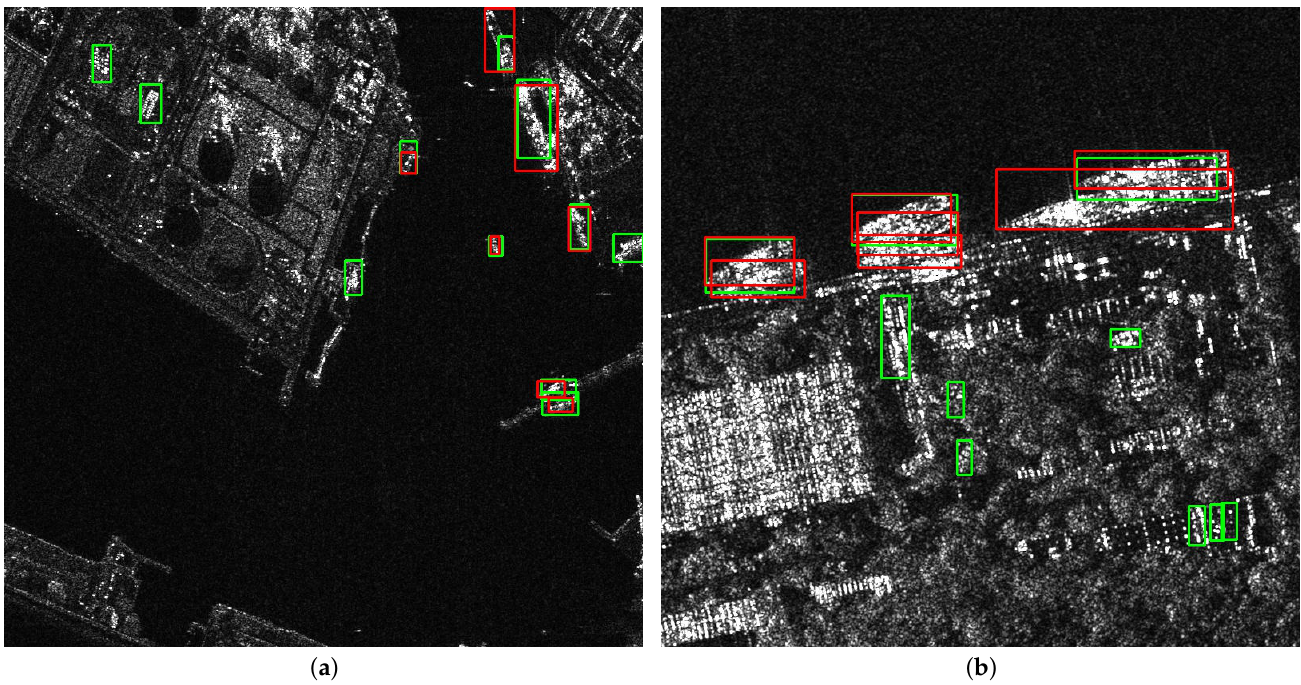
Figure 10. ( a , b ) Some cases of unsuccessful results. The red bounding box denotes ground-truth and the green bounding box denotes the predicted